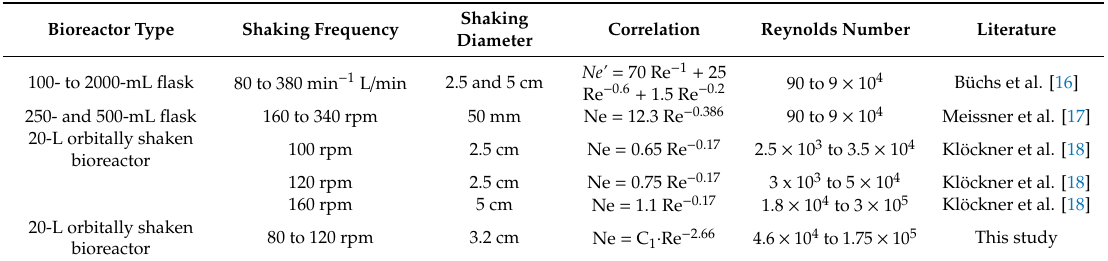
Table 4. Correlation between Newton number and Reynolds